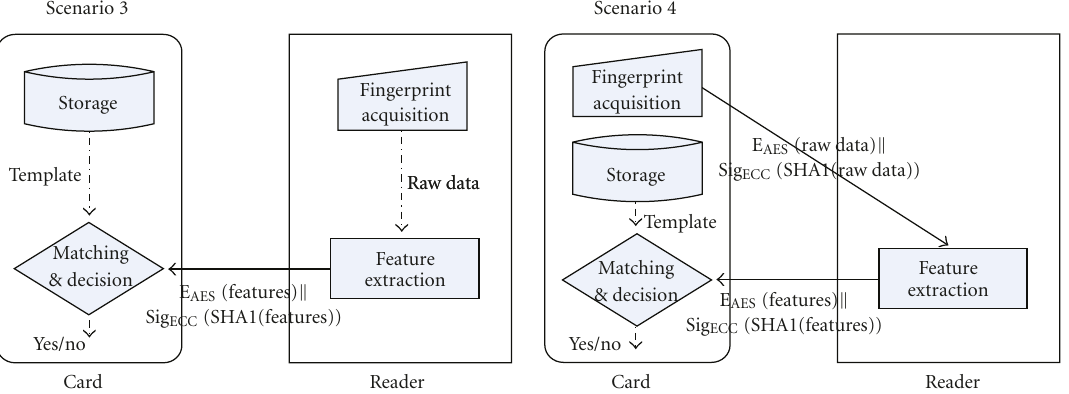
Figure 2: Illustration of the integrating scenarios [23–26] for match-on-card and the corresponding X9.84 [27] implementations.